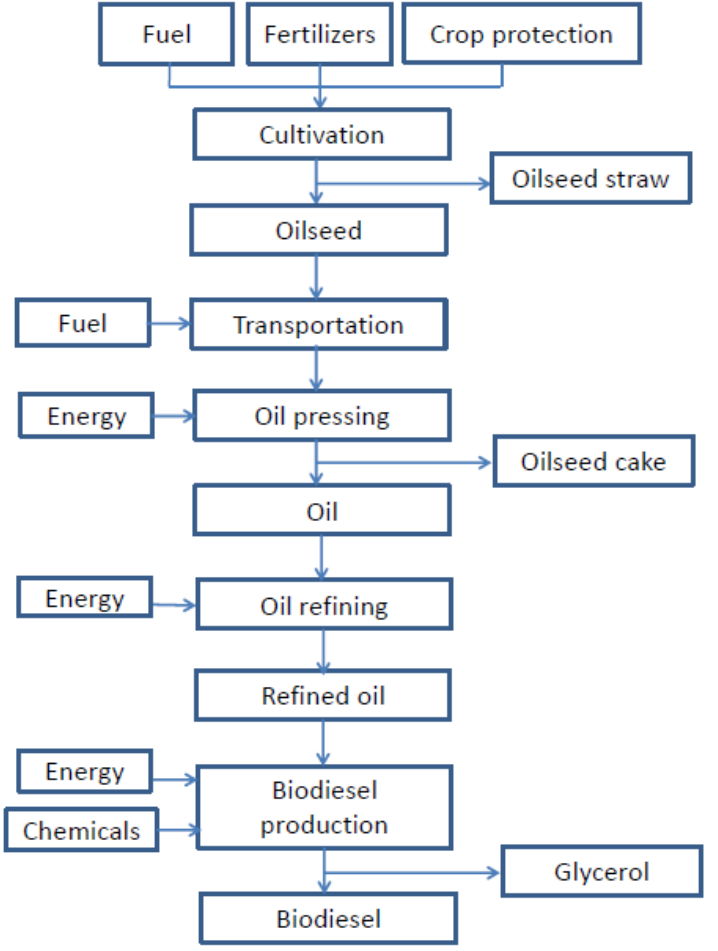
Figure 1. Life cycle stages of biodiesel.